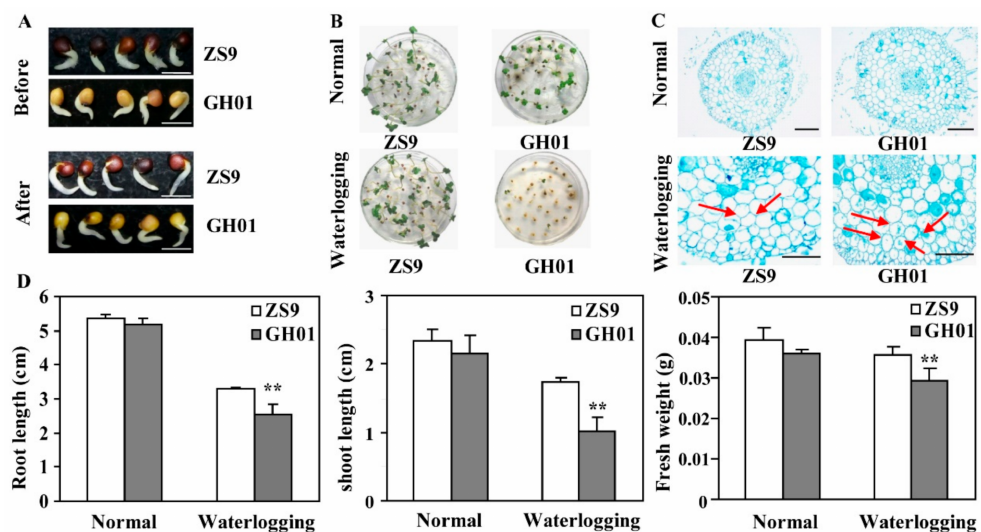
Figure 1. Effects of waterlogging stress on root growth. ( A ) Phenotypes of germinated seeds from ZS9 and GH01 before and after waterlogging stress for 12 h (bar = 0.5 cm); ( B ) Phenotypes of seedling emergence from ZS9 and GH01 under normal conditions and waterlogging stress conditions; ( C ) Transverse view of the ZS9 and GH01 radicles before and after waterlogging stress for 12 h. The sections were excised from root at 0.5 cm above the root tips, stained with toluidine blue, and photographed under stereoscopic microscope (scale bar = 0.25 mm); ( D ) Root length, shoot length, and fresh weights of ZS9 and GH01 under normal conditions and waterlogging stress conditions for three days (asterisks indicate statistically significant differences between ZS9 and GH01 at ** p < 0.01). Error bars present standard deviations based on three biological repetitions.